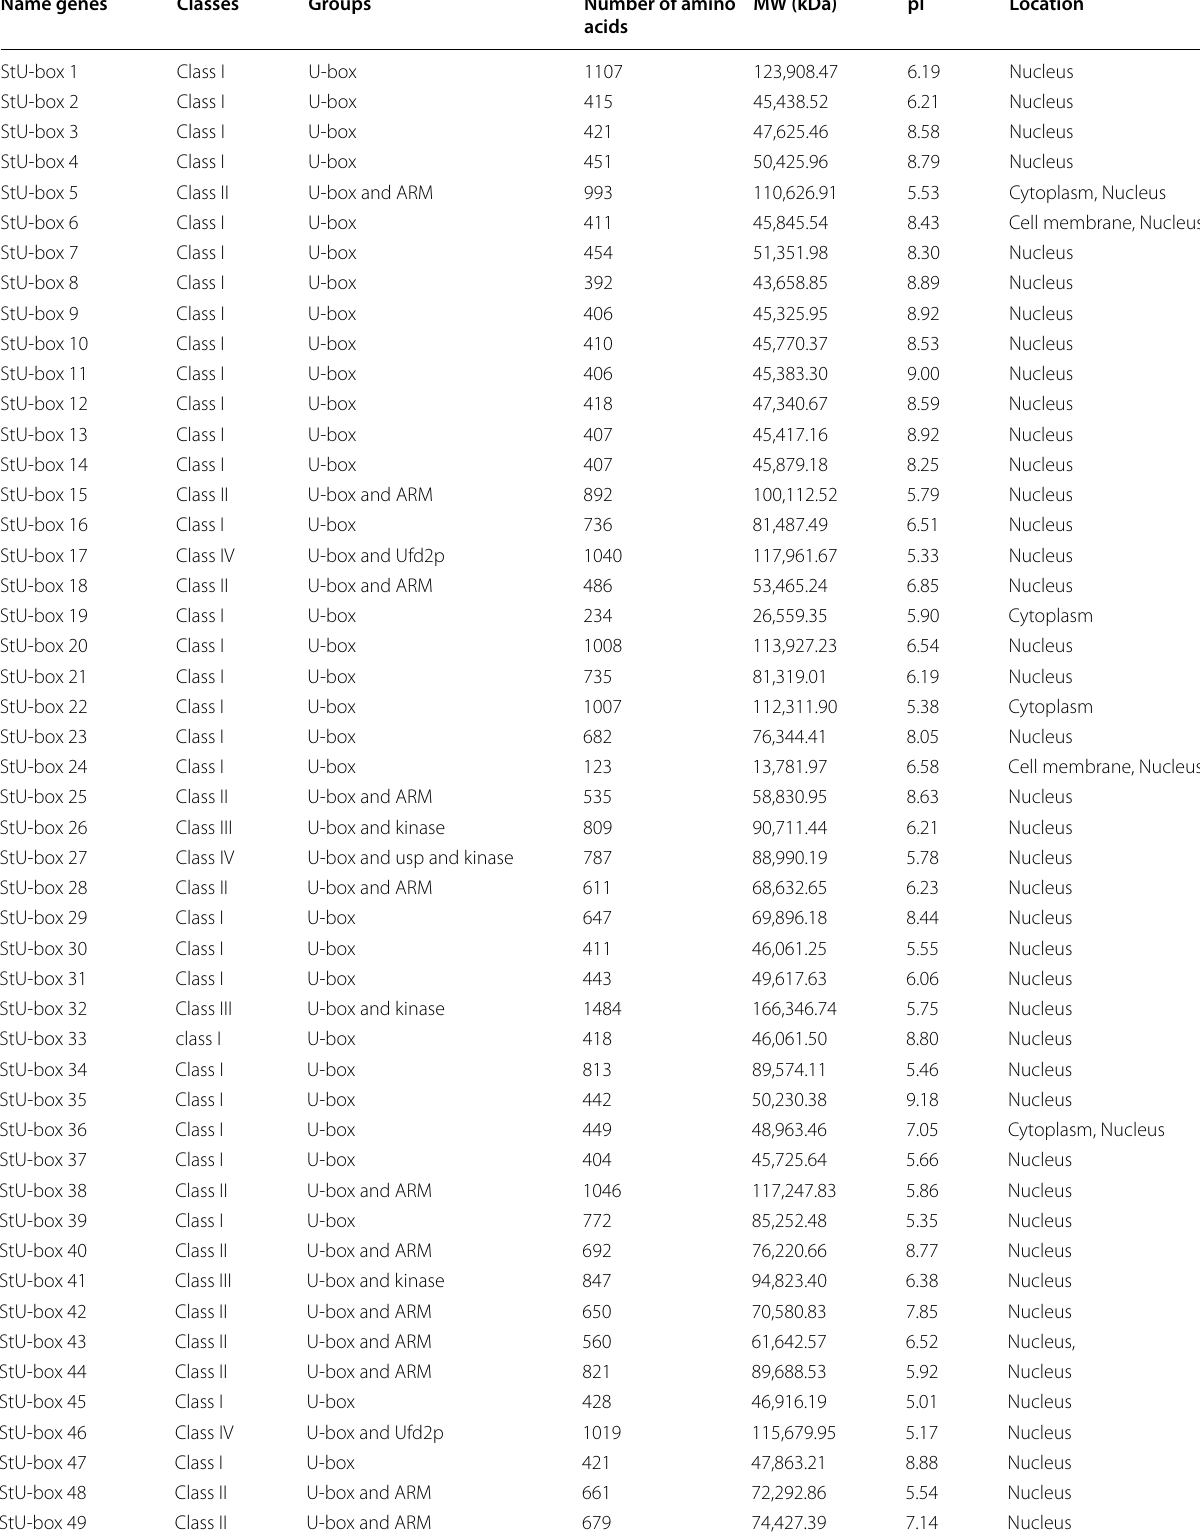
Table 1 Characterization of StU-box genes in